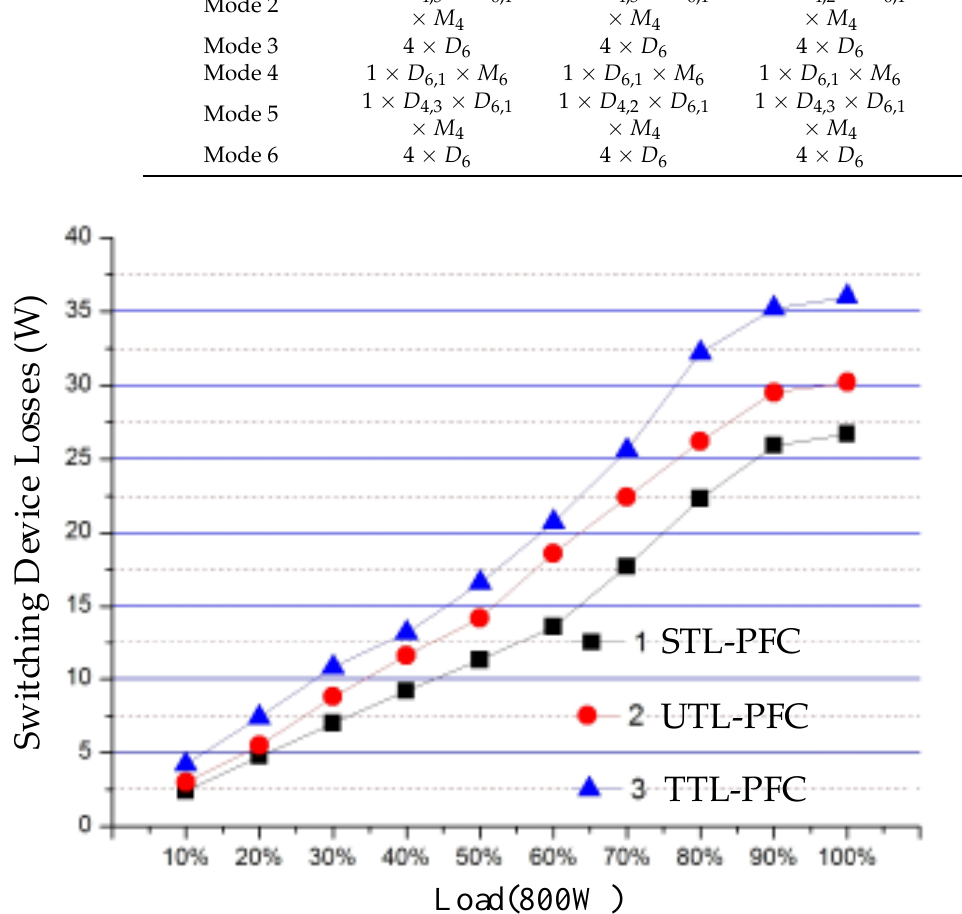
Figure 7. Switching device losses of three PFC topologies under different load conditions.